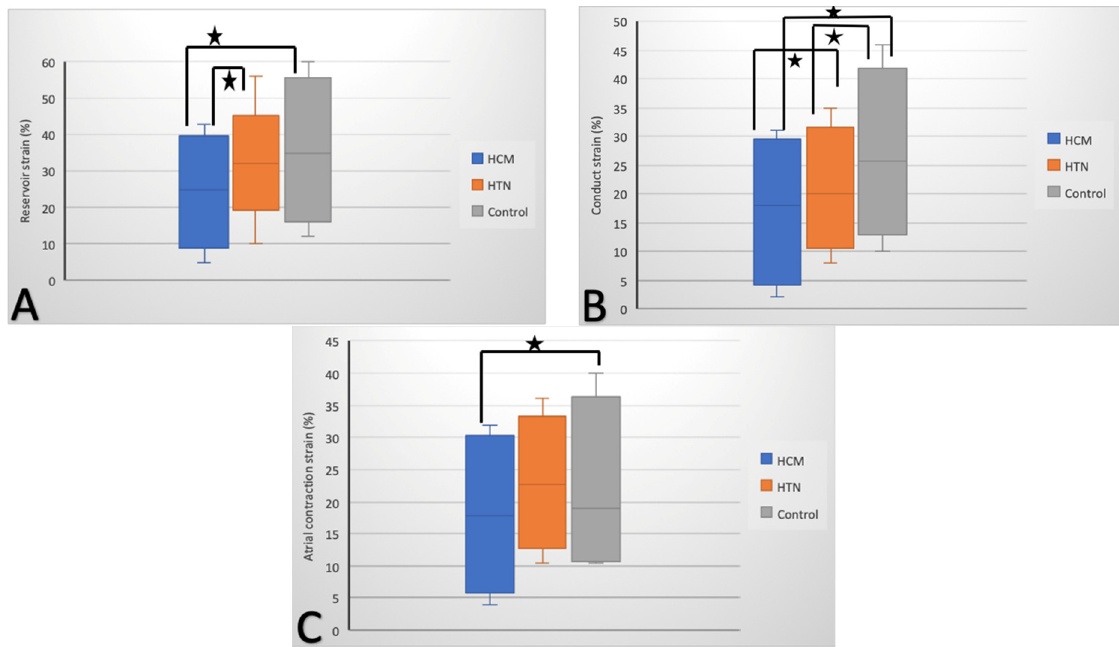
Figure 1. Left-atrial reservoir ( A ), conduit ( B ), and atrial contraction ( B ) strain (%) in patients with hypertrophic cardiomyopathy (HCM), patients with hypertension (HTN), and controls; * p < 0.05 for HCM–control and HCM–HTN comparisons ( A ), for HCM–control, HCM–HTN, and HTN–control comparisons ( B ), and for HCM–control comparisons ( C ).